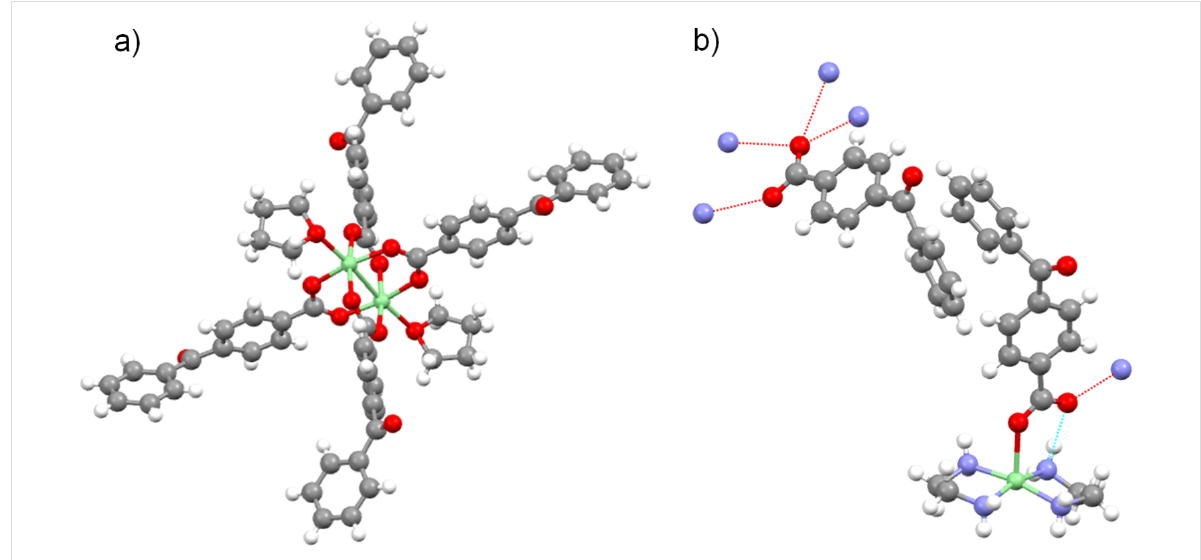
Figure 1: a) Molecular structure of 4 (a THF molecule present in the unit cell is not shown). Cu, green; C, grey; O, red; H, white; b) Molecular struc- ture of 1 (asymmetric unit) showing the intermolecular (dashed red lines) and intramolecular (dashed blue line) H-bond interactions of the carboxylate C=O bonds with surrounding H–N bonds. Cu, green; N, blue; C, grey; O, red; H, white. CIF files for the determined structures are available as Supporting Information File 2 and Supporting Information File 3 and are also available on request from the Cambridge Crystallographic Data Centre as deposition CCDC 1414149 for 4 , and CCDC 1410011 for 1 .